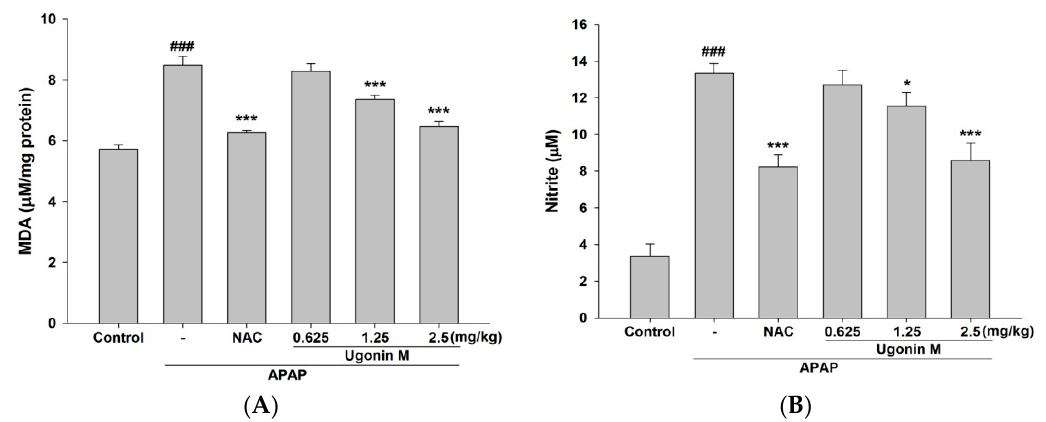
Figure 4. Effects of Ugonin M on ( A ) liver peroxide level and ( B ) serum nitric oxide (NO) level. Data are expressed as M ± SD ; n = 6 .